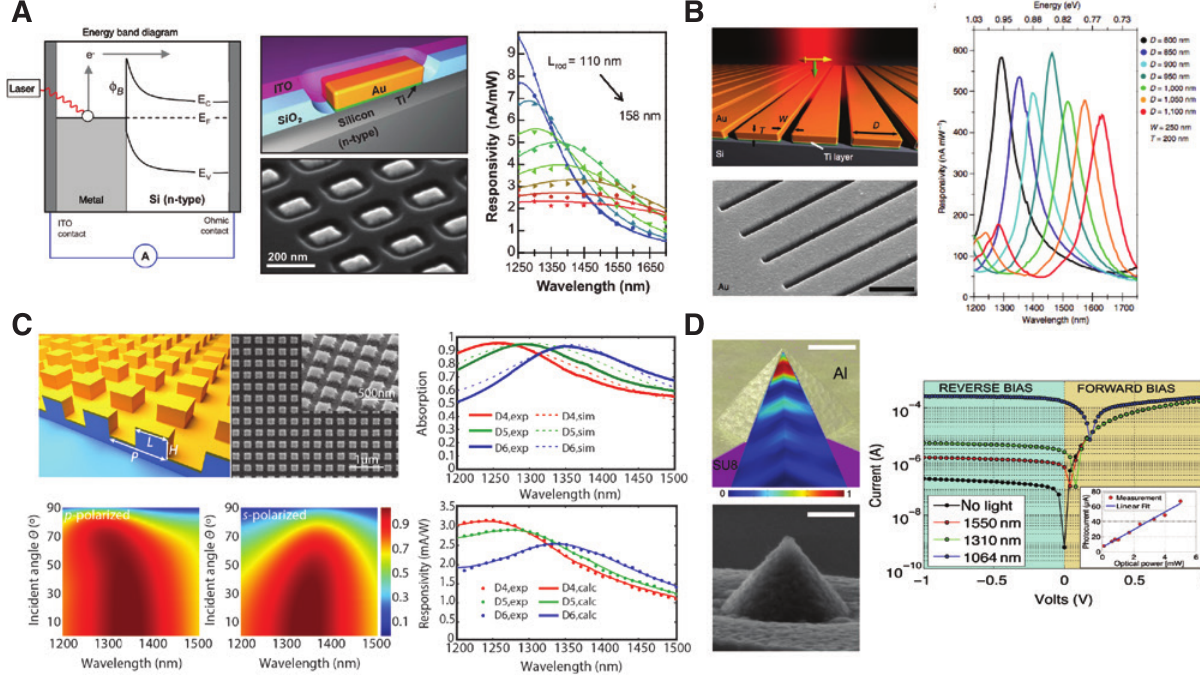
Figure 2: Schottky interface-based free-space hot electron photodetectors. (A) Left: Band diagram for plasmonically driven internal photoemission over a nanoantenna-semiconductor Schottky barrier.